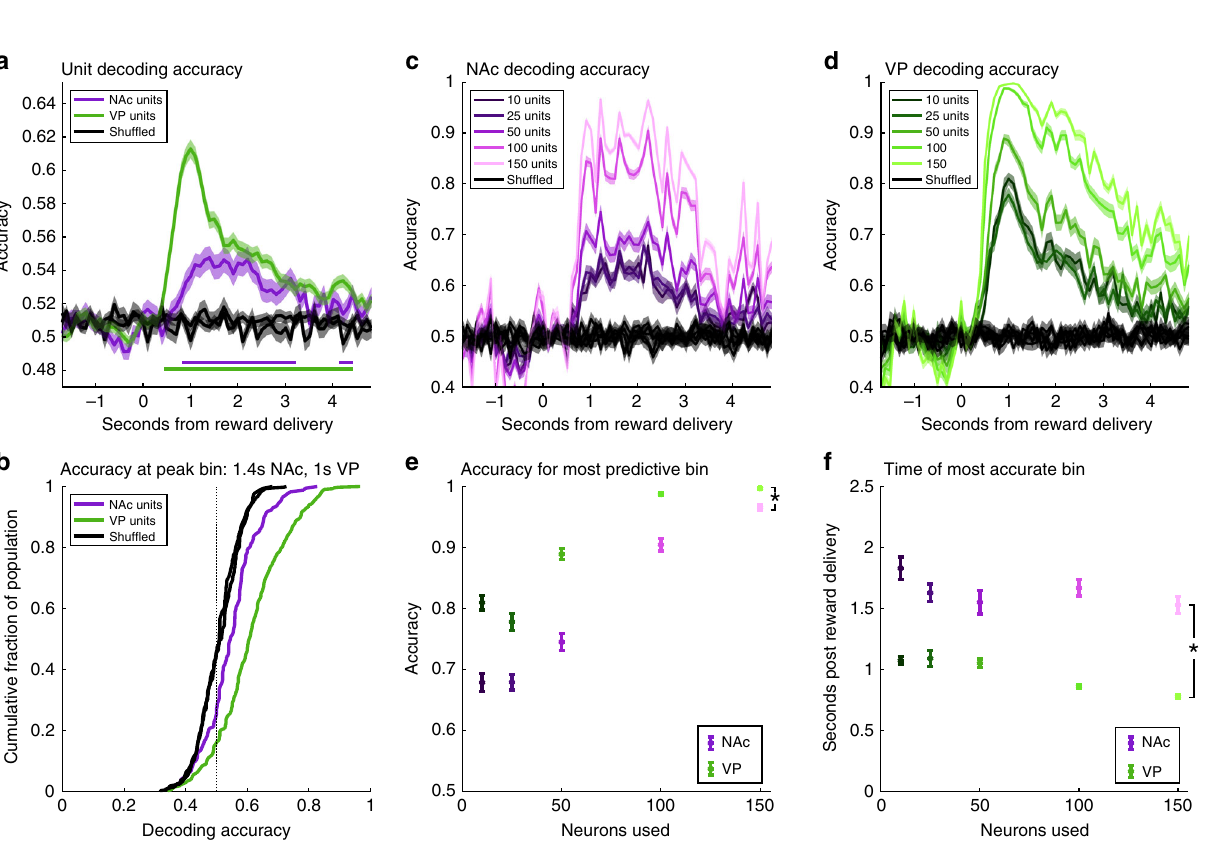
Fig. 3 VP activity decodes trial identity earlier and more accurately than NAc activity. a Average cross-validated decoding accuracy relative to reward delivery time, determined using linear discriminant analysis models trained on spiking data of individual neurons across 600 ms overlapping bins. Decoding accuracy for NAc (purple), VP (green), and data with shuf fl ed trial identity from each region (black). Shading is SEM. Purple (NAc) and green (VP) lines indicate consecutive bins where accuracy exceeds 99% con fi dence interval of corresponding shuf fl ed data. b Cumulative distribution of accuracies in the bin with the greatest average accuracy in each region (centered at 1.4 s in NAc and 1 s in VP) and the corresponding shuf fl ed data from that bin in each region. c Average cross-validated decoding accuracy of linear discriminant analysis models trained on spiking data of 20 randomly selected groups of 10, 25, 50, 100, or 150 neurons in NAc across 600 ms overlapping bins relative to reward delivery time and corresponding models trained on data with trial identity shuf fl ed. Shading is SEM. d Same as ( c ) for VP pseudoensemble models. e Average accuracy of each replicate for the bin with peak accuracy for each pseudoensemble size in each region. Asterisk indicates signi fi cant main effect of region on accuracy (F(1,490) = 212, p = 3.3E-40). f Average peak accuracy time post-reward for each replicate of each pseudoensemble size in each region. Asterisk indicates signi fi cant main effect of region on peak accuracy time (F(1,490) = 289, p = distribution function (CDF) (Fig. 3b), corresponding to a sig- conducted the analysis 20 more times with 182 randomly chosen ni fi cantly greater improvement in accuracy over shuf fl ed data in VP units. The fi rst bin signi fi cantly more accurate than shuf fl ed VP (shuf fl ed vs true X region: F(1,1154) = 13.6, p = 0.00037). data ranged from 0.4 – 0.6 s (median 0.5 s), consistently earlier Notably, VP single units fi rst improved over shuf fl ed data for the than 0.9 s in NAc. bin centered at 0.5 s, whereas NAc single units fi rst improved over shuf fl ed data at 0.9 s (purple and green lines in Fig. 3a). To control for the larger number of neurons recorded in VP, we